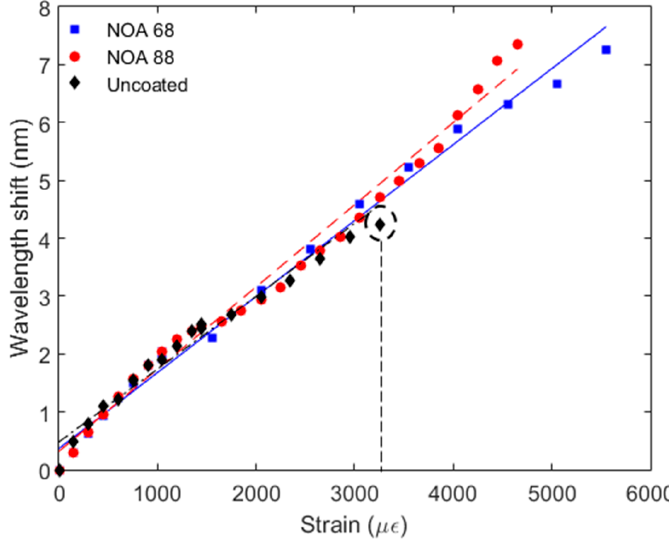
Figure 6. Strain responses of the uncoated, NOA 68 and NOA 88 coated samples .